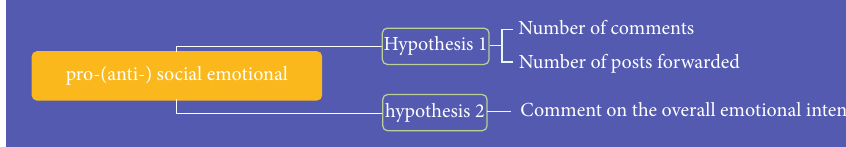
Figure 1: The research hypotheses and the core